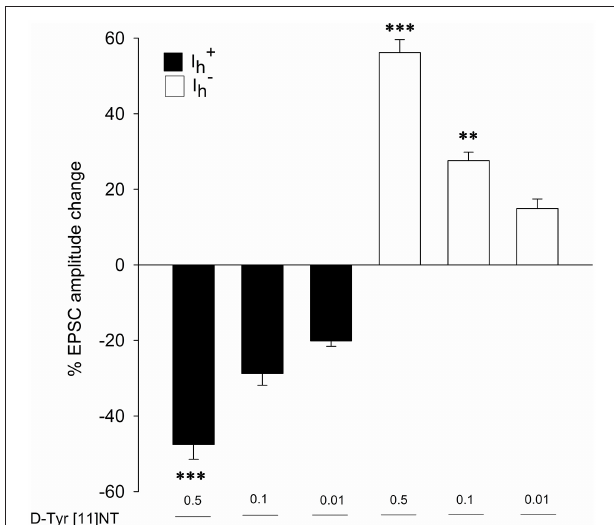
FIGURE 5 | Effects of [D-Tyr 11 ]NT on glutamatergic EPSCs in I + h and I − h neurons. Mean percent change in EPSC amplitude recorded in I + h (black bar) and I − h (white bar) following application of different concentrations of [D-Tyr 11 ]NT. The number of neurons recorded at each concentration is as follow: 0.01 µ M, n = 12 (I + h n = 6 , I − h n = 6 ); 0.1 µ M, n = 12 (I + h n = 6 , I − h n = 6 ); 0.5 µ M, n = 16 (I + h n = 7 , I − h n = 9 ). All concentrations of D-Tyr[11]NT are reported in µ M. Asterisks indicate a statistically significant difference with the lowest concentration ( ** p < 0.05 ; *** p < 0.001 ). See text for